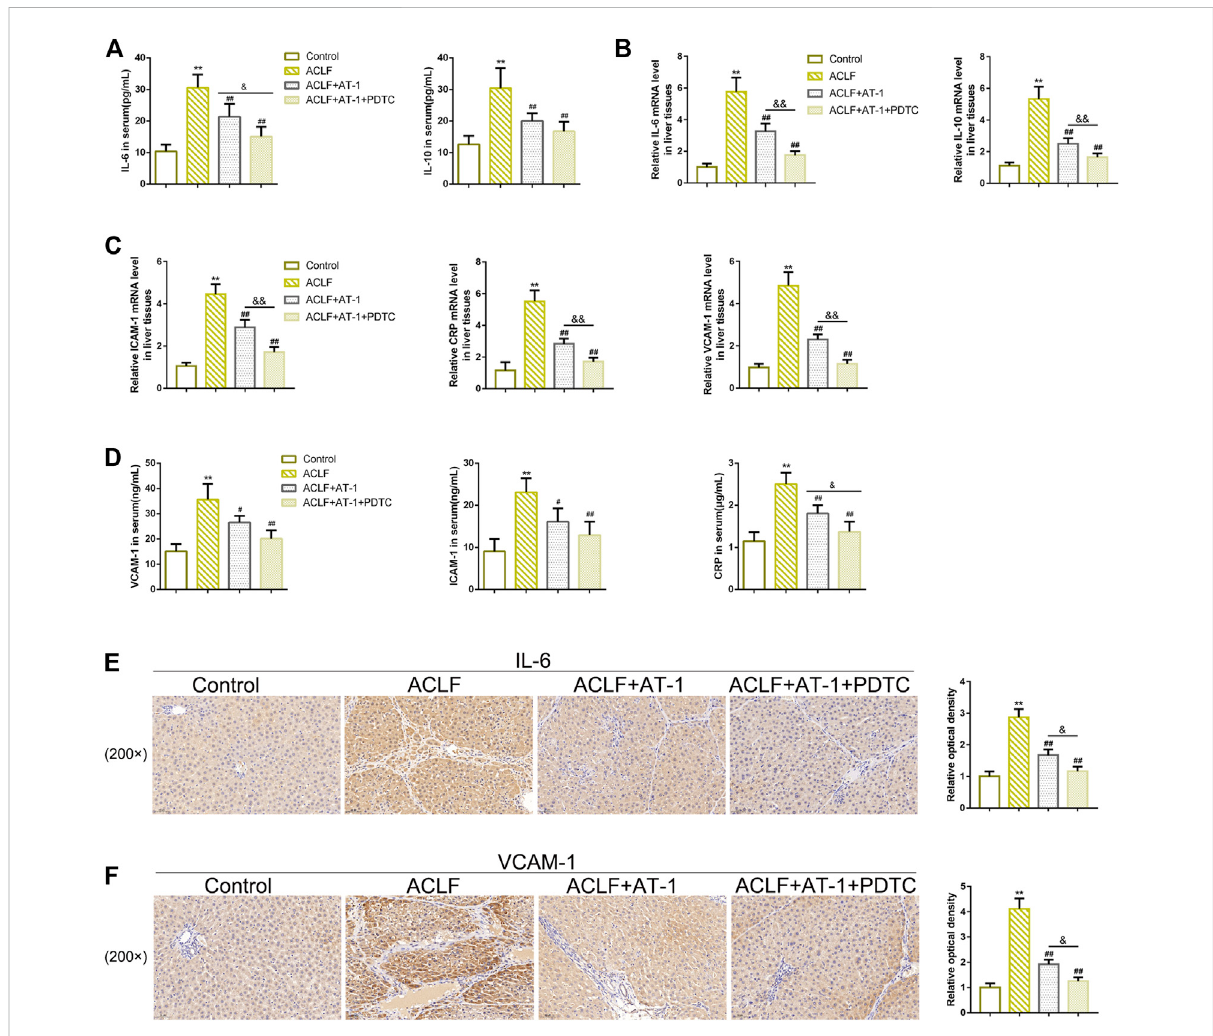
FIGURE 8 NF- κ BsignalingisinvolvedinAT-1effectsonin fl ammationinmodelrats. (A – D) LevelsofIL-6,IL-10,VCAM-1,ICAM-1,andCRPwereexamined usingELISAintheserumorqRT-PCRassayinlivertissues. (E – F) LevelsofIL-6andVCAM-1inlivertissueswereexaminedbyIHCstaining.N=6;** p < 0.01 compared to the control group; ## p < 0.01 compared to the ACLF model group; & p < 0.05 and && p < 0.01 compared to ACLF+AT-1